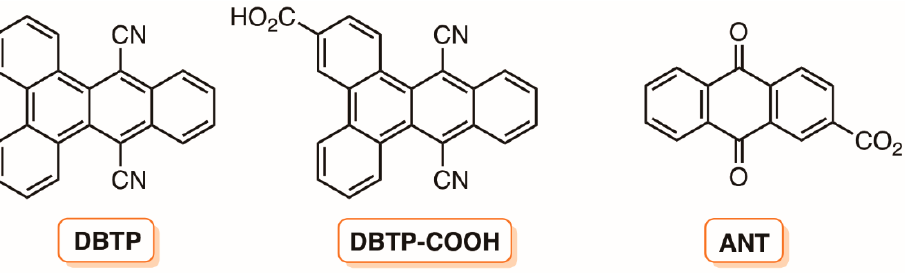
Figure 15. Structures of the two different PSs covalently linked to silica [104].